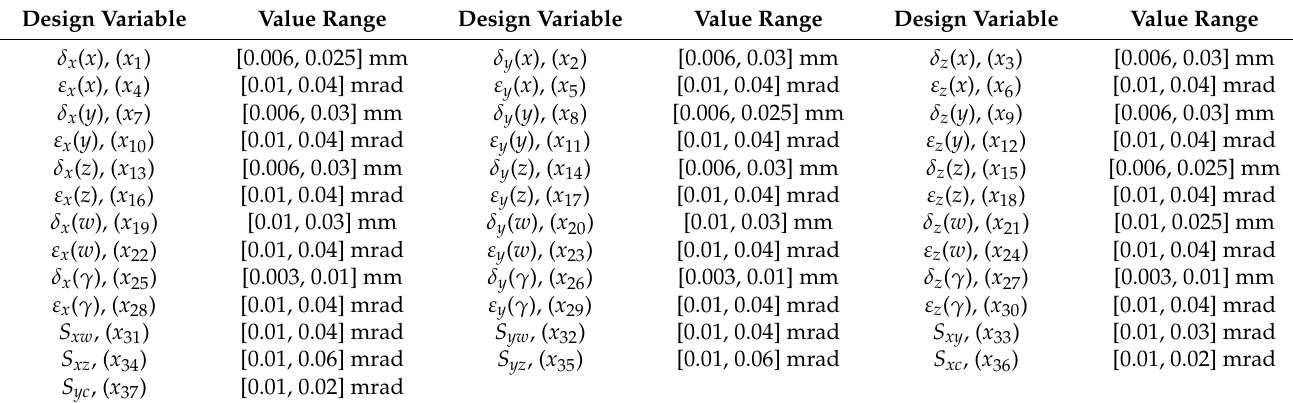
Table 2. Value ranges of design variables of static